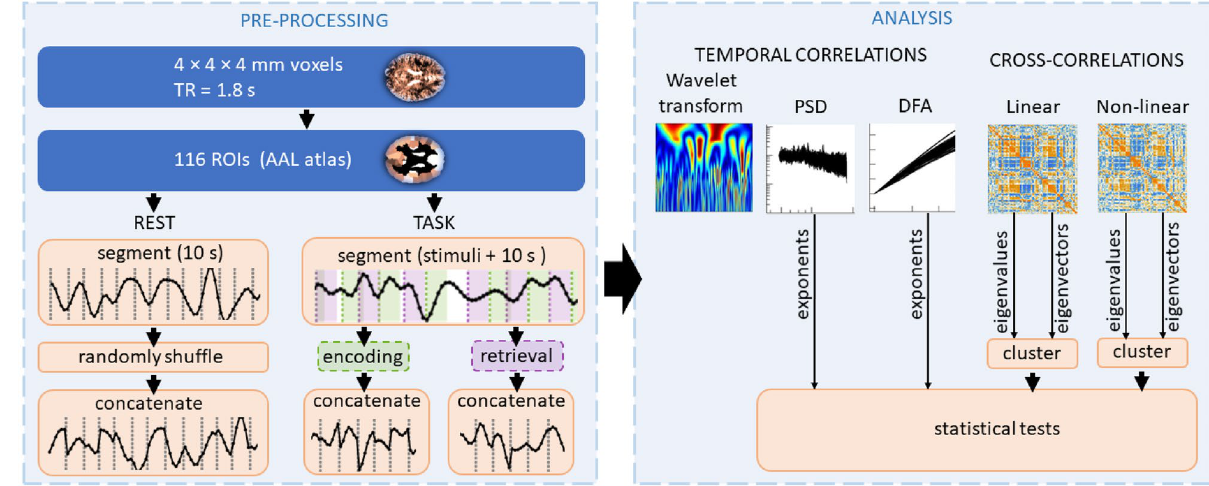
Figure 1. Flow chart of data preprocessing and analysis performed as described in detail in “Data” and